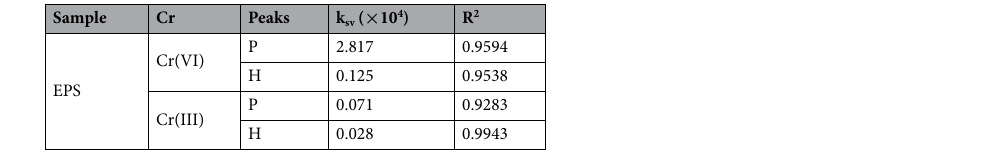
Table 4. Complexation parameters of Cr with the